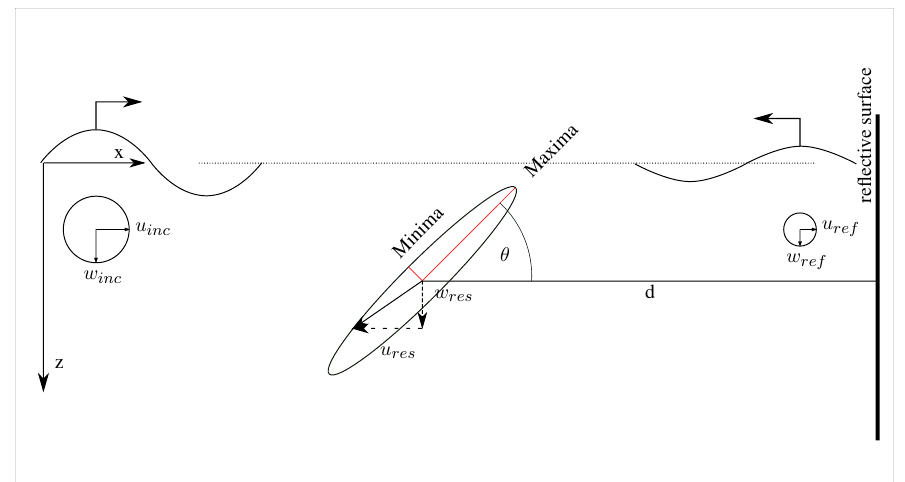
Figure 1. Schematic representation of water particle velocities for different water depths